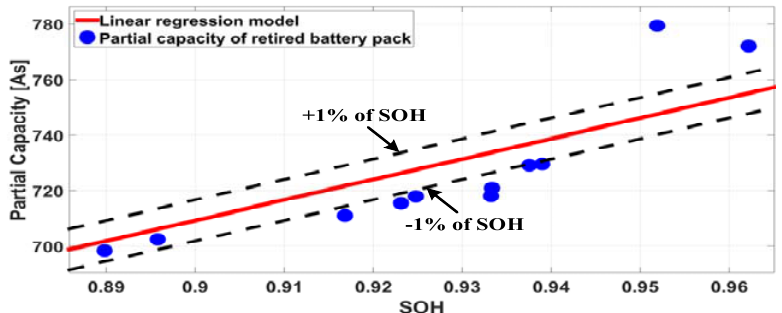
Figure 22. Comparison between the linear regression model based on the IC curve peak point of cell no. 1 and a real SOH based on the IC curve peak point of the 12 series ‐ connected stages of the retired series/parallel battery pack.